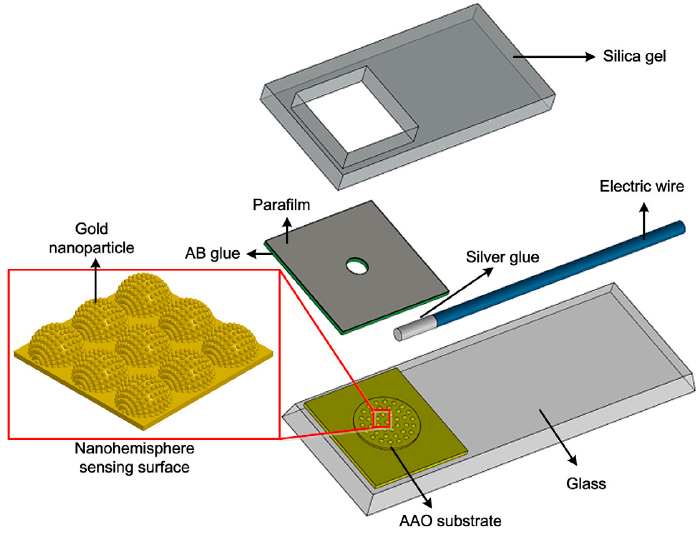
Figure 5. Schematic of the fabrication process of nanostructured biosensor [52]. Copyright 2014. Reproduce with permission from Elsevier Inc.